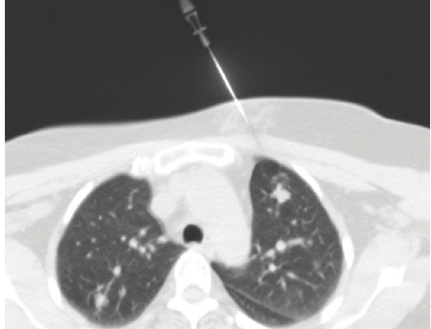
Figure 2: The needle advances toward the nodule in the anterior segment of the left lung during transthoracic biopsy.